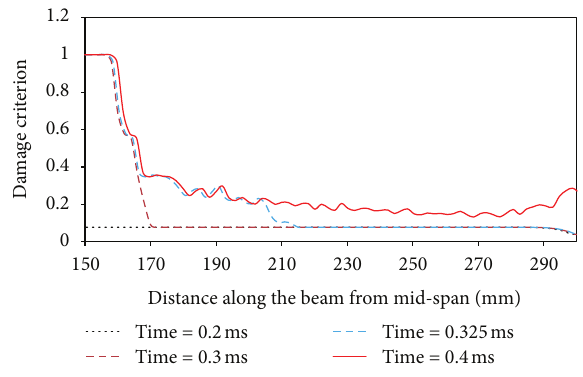
Figure 14: The distribution of the damage criterion for epoxy between CFRPs along the beam span.